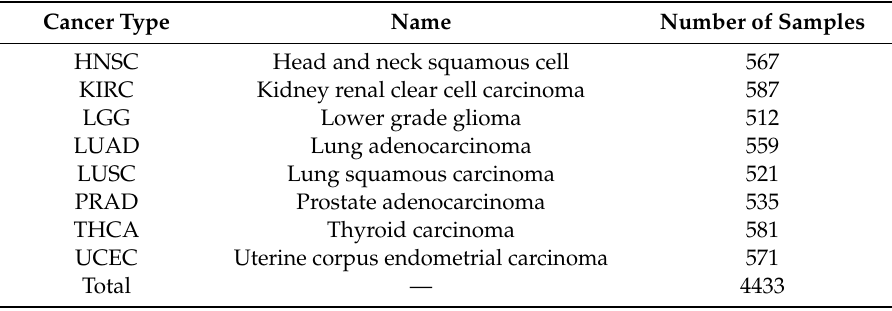
Table 3. Sample sizes of eight major cancer